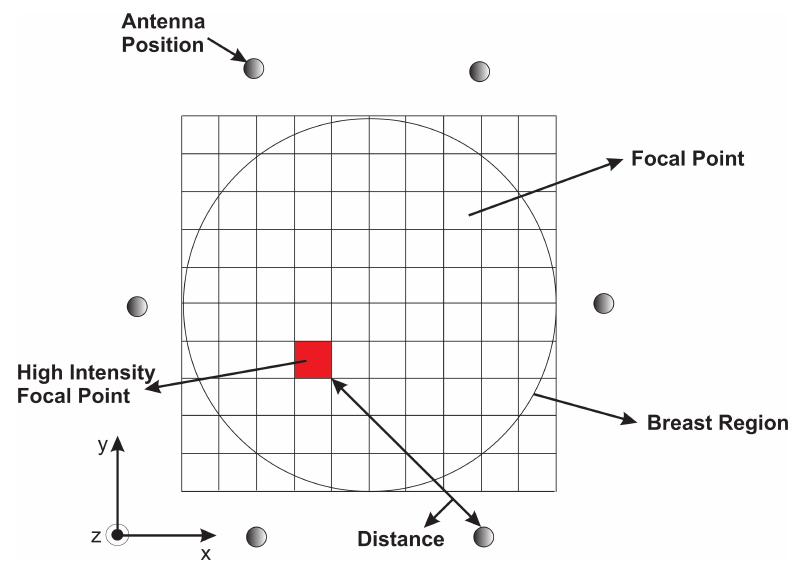
Figure 6. A representation of the monostatic